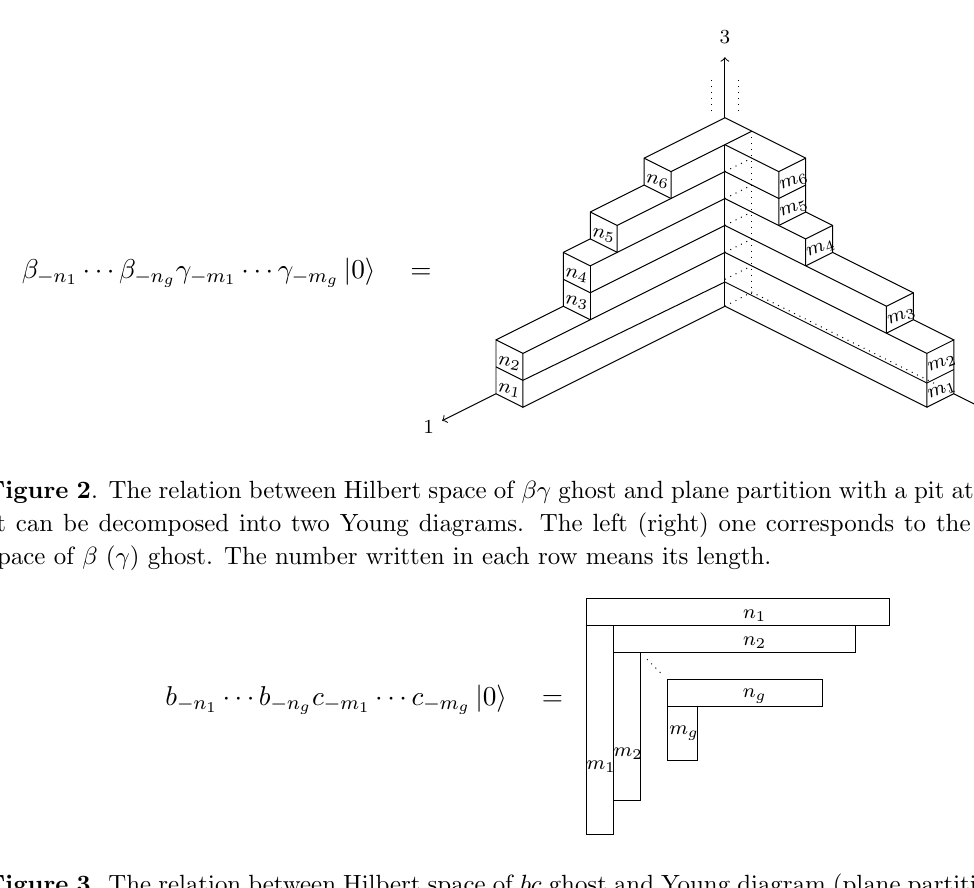
Figure 3 . The relation between Hilbert space of bc ghost and Young diagram (plane partition with a pit at (1,1,2)). The number written in each row or column means its